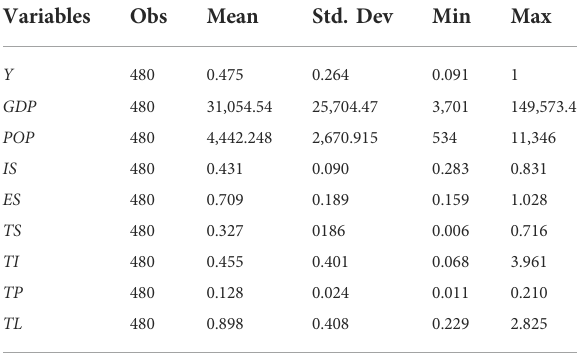
TABLE 1 Descriptive statistics of the variables.